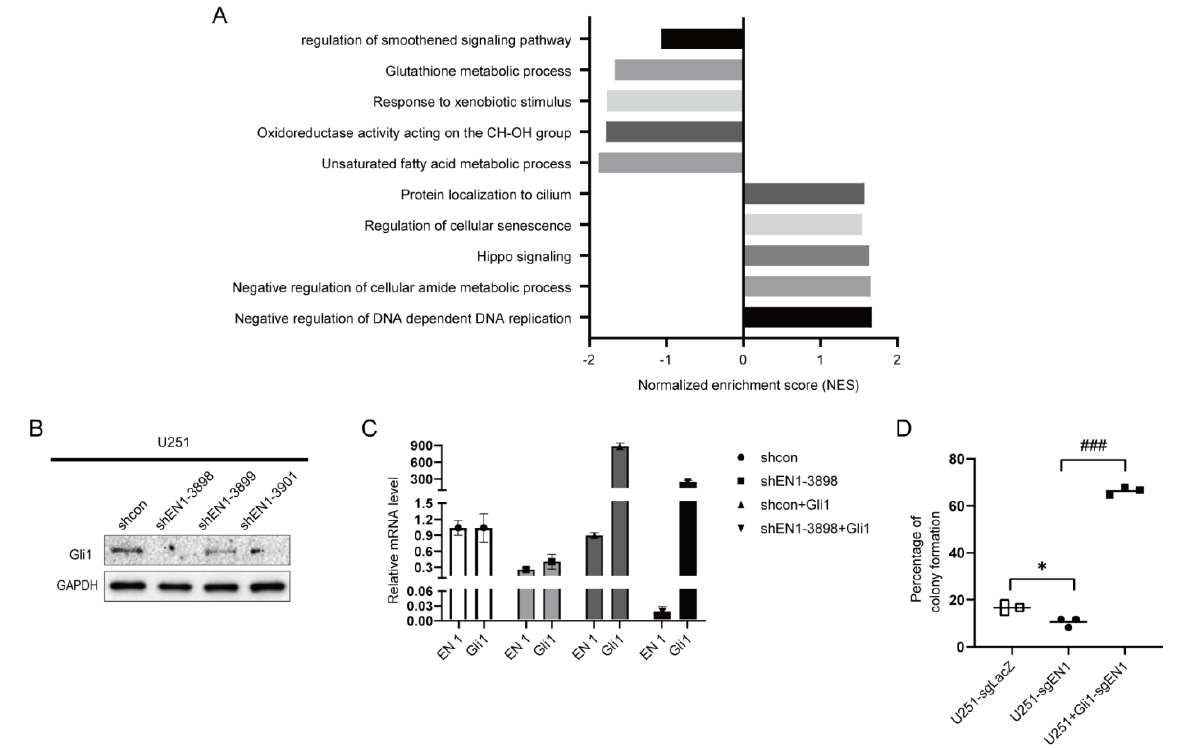
Figure 4. EN1 increases the activity of proliferation related Hedgehog signaling pathways. ( A ) Overrepresented Gene Ontology (GO) terms from RNA − seq analysis of upregulated gene sets and downregulated gene sets in EN1 knockdown group compared to control cells. ( B ) Immunoblotting assays showing that EN1 knockdown significantly reduces the Gli1 level in glioma cells. ( C ) The EN1 and Gli1 transcript levels in U251 cells transduced with scramble control, shEN1, shcon + Gli1, or shEN1 + Gli1. ( D ) Overexpression of Gli1 rescues the restrained colony-forming abilities caused by the knockout of EN1 ( (cid:3) for U251-sgLacZ, • for U251-sgEN1, (cid:4) for U251+Gli1-sgEN1). Data are presented as the mean from three independent experiments. * p < 0.05, ### p < 0.001 according